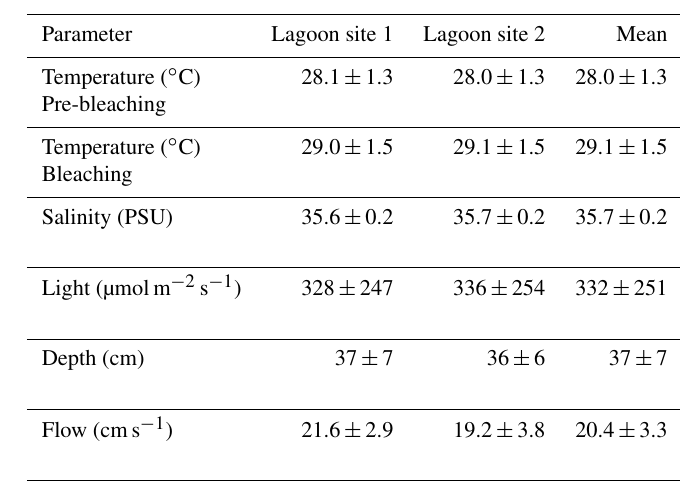
Table 2. Mean values for physiochemical parameters measured at lagoon site 1 and lagoon site 2 over the course of the study. Temperature and light were logged continuously at 15min intervals. Temperature data are separated by the pre-bleaching period (22 January–1 February 2020) and bleaching period (2–10 February 2020). Salinity was measured with each collected water sample ( n = 60 per site). Depth was measured at peak low tide at 5m intervals along each transect ( n = 120 per site). The flow meter was rotated between downstream water sample collection locations on each day of collection ( n = 5 per